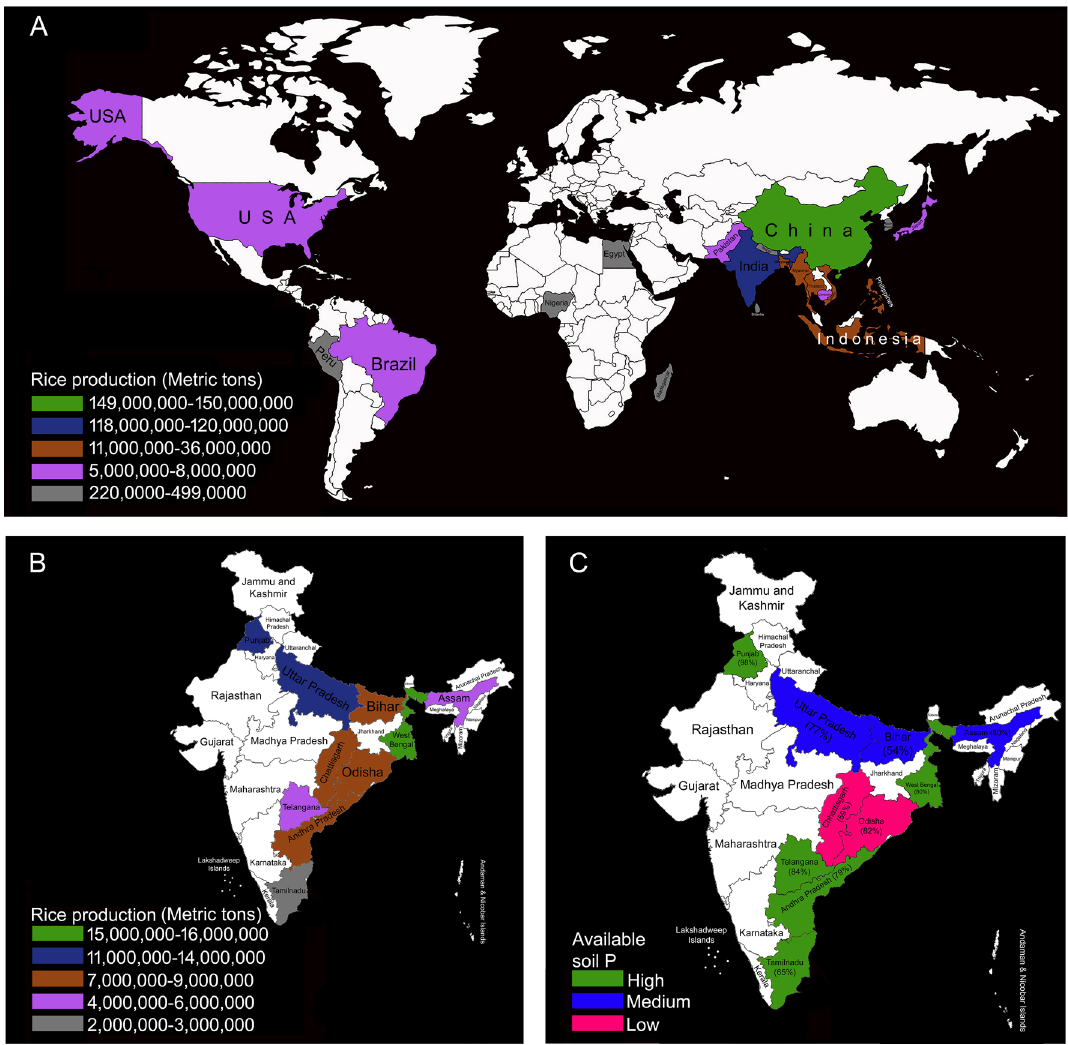
Figure 1. Rice producing (metric tons) ( A ) top 20 countries (www. world agric ultur alpro ducti on. com/ crops/ rice. aspx) and ( B ) top 10 states in India (www. mapso findia. com/ top- ten/ india- crops/ rice. html). ( c ) Available soil P content (high, medium, and low) in top 10 states in India producing rice (www. iiss. nic. in/ distr ictmap. html). Photoshop 7.0 version was used to prepare the figure A – C